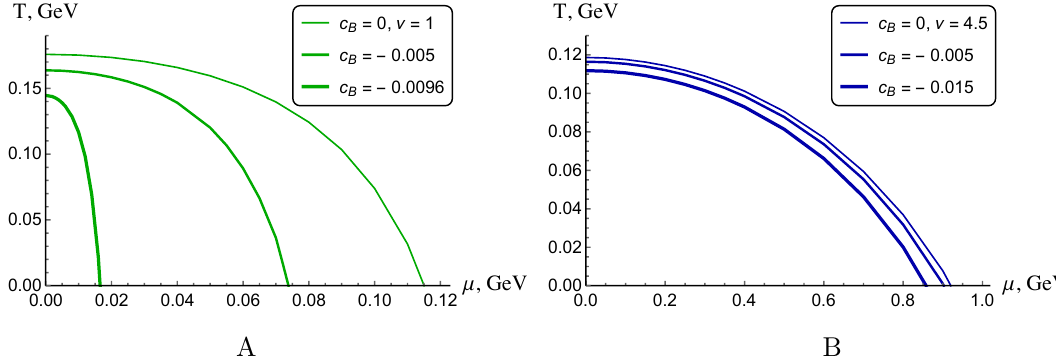
Figure 13 . Wilson loop transition lines for WLy 2 , different c B and for ν = 1 (A) and ν = 4 . 5 (B); c = 0 . 227 .